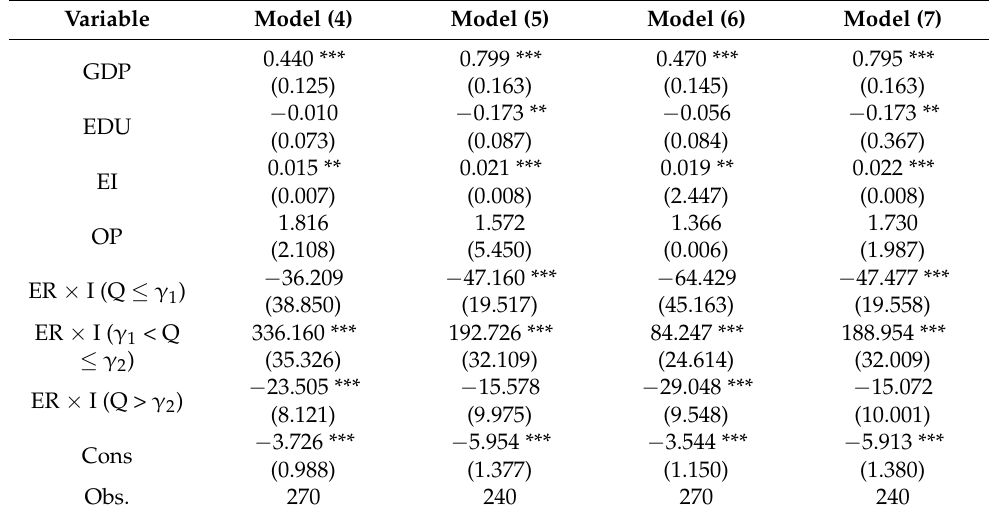
Table 9. Robustness test